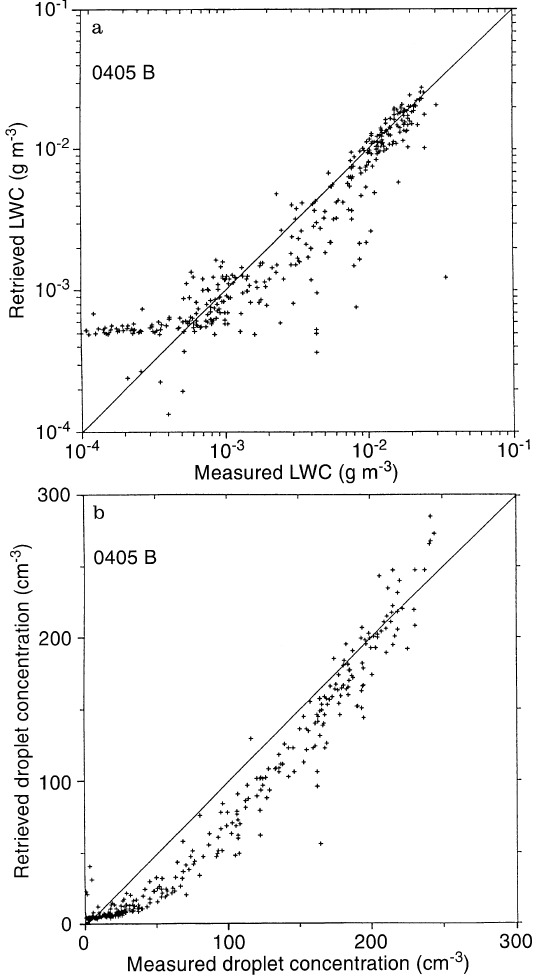
Fig. 6a, b. Correspondence between the retrieved and direct measure- ments (plotted at 1 Hz) of droplet concentration and liquid water content